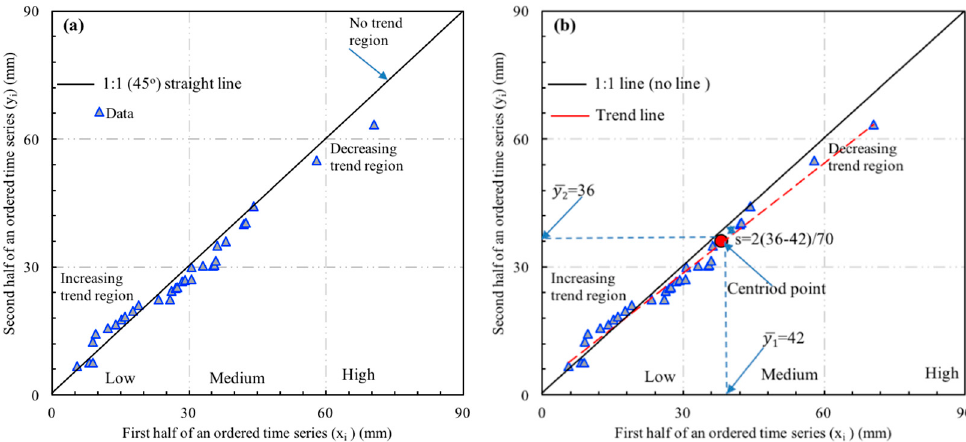
Figure 2. Illustration of the Ş en’s method [46,55] ( a ) The increasing, decreasing, and no trend (trendless) in the ITA method; ( b ) The innovative trend slope.